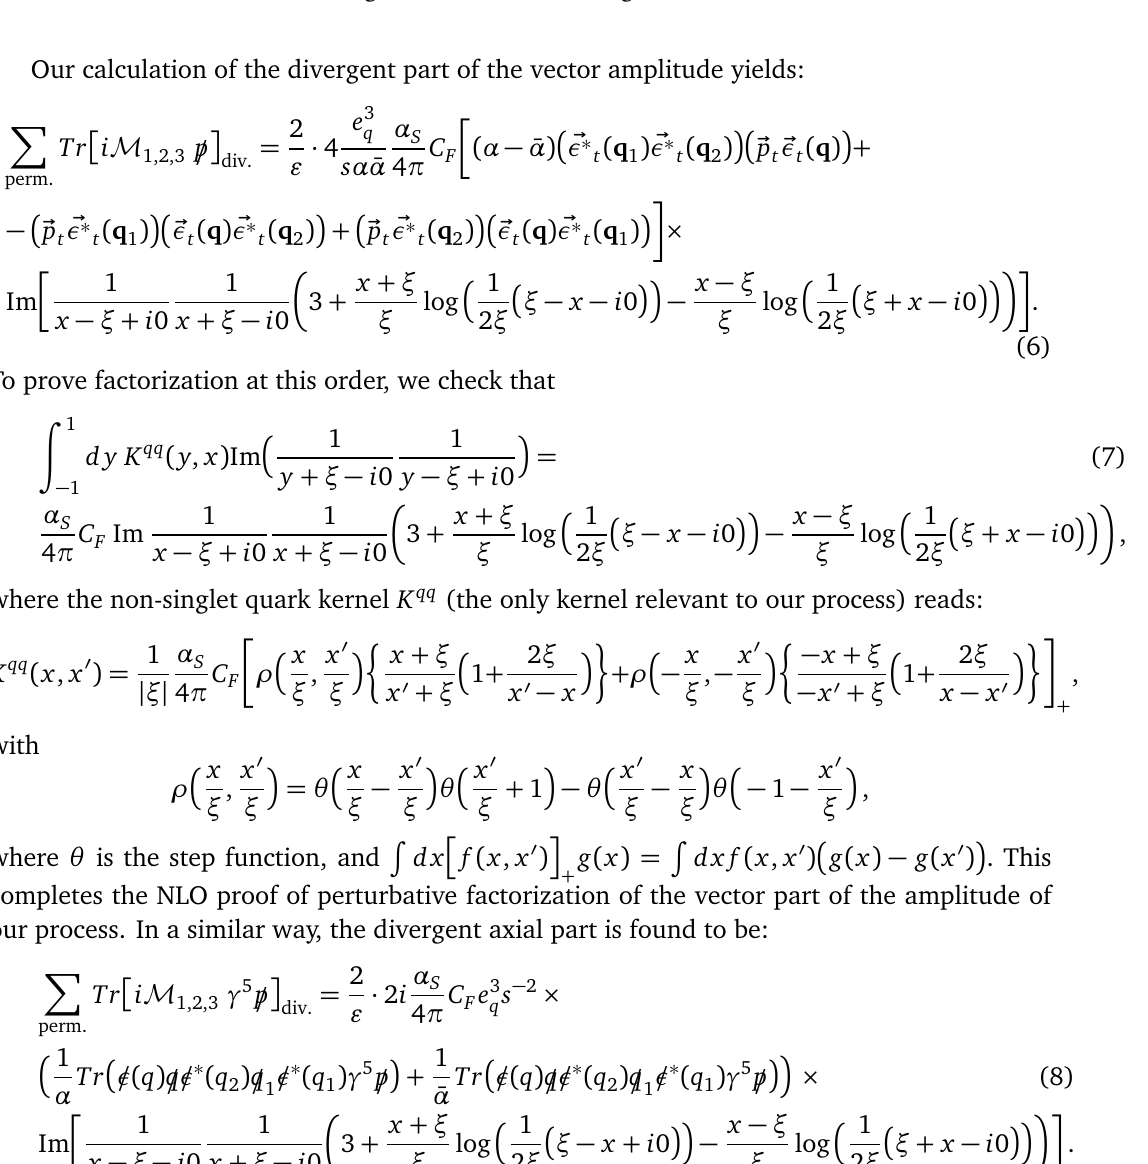
Figure 3: Some NLO